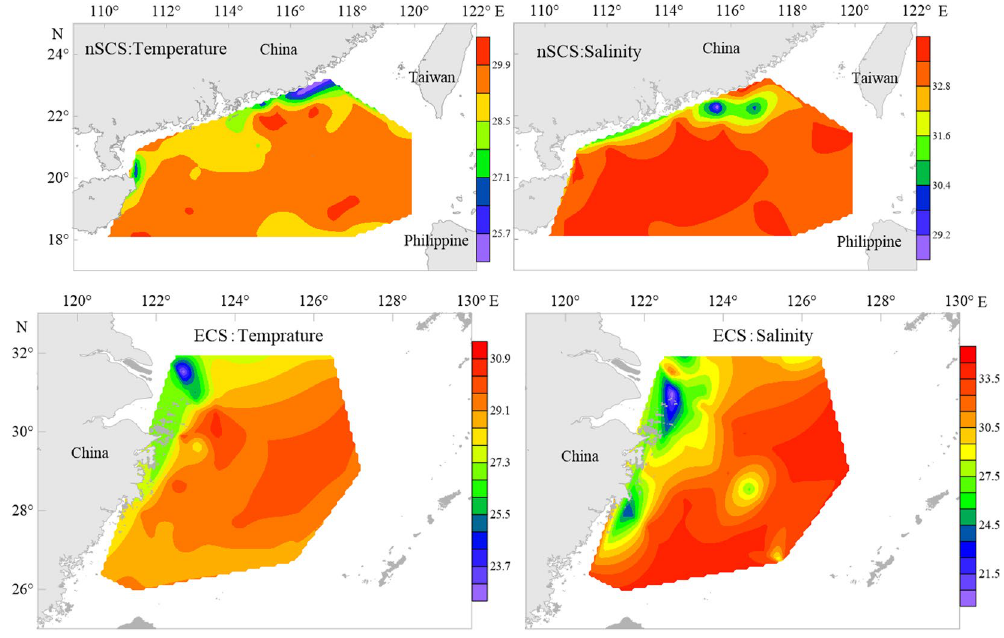
Figure 1. Surface sea temperature and salinity in the northern SCS and East China Sea. Note for software: Golden Software Surfer 11